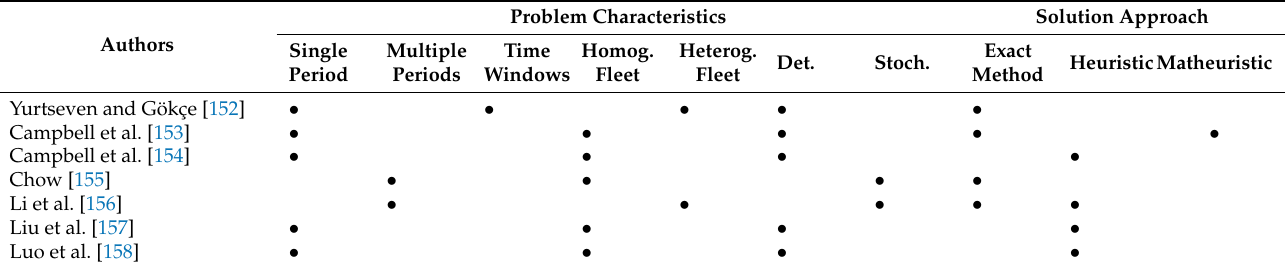
Table 2. Classification of the revised E-ARP papers according to the problem characteristics and the solution approach.